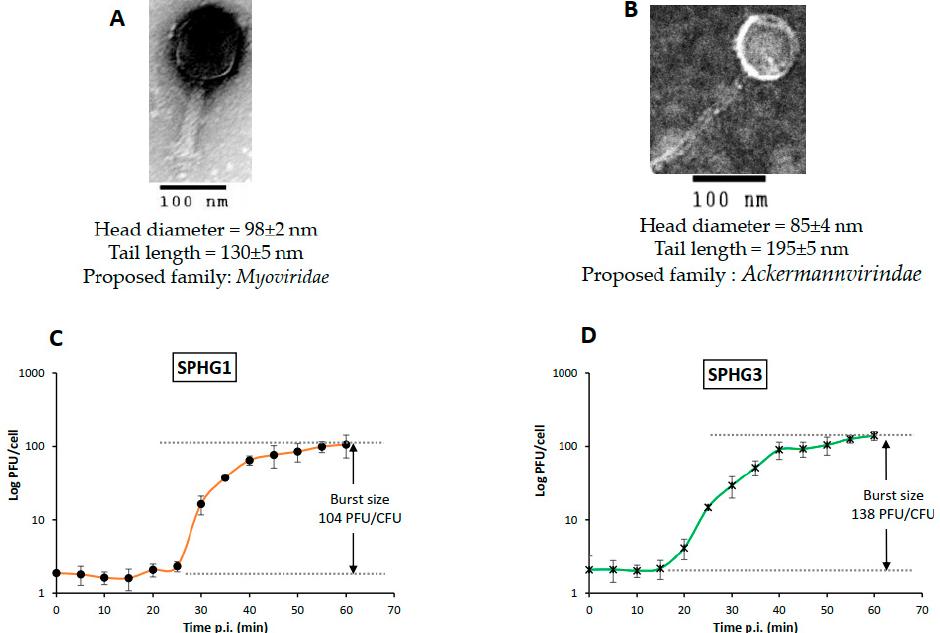
Figure 2. Morphology and Growth kinetics of phages SPHG1 and SPHG3: ( A , B ) Transmission Electron Microscope analysis of phages SPHG1 and SPHG3, respectively, head and tail measurements of each phage are represented below each micrograph, scale bar = 100 nm and ( C , D ) one-step growth curves of SPHG1 and SPHG3 phages on S. Typhimurium EG.SmT3. The data shown are the mean of three replicates and error bars show the deviation in the values.